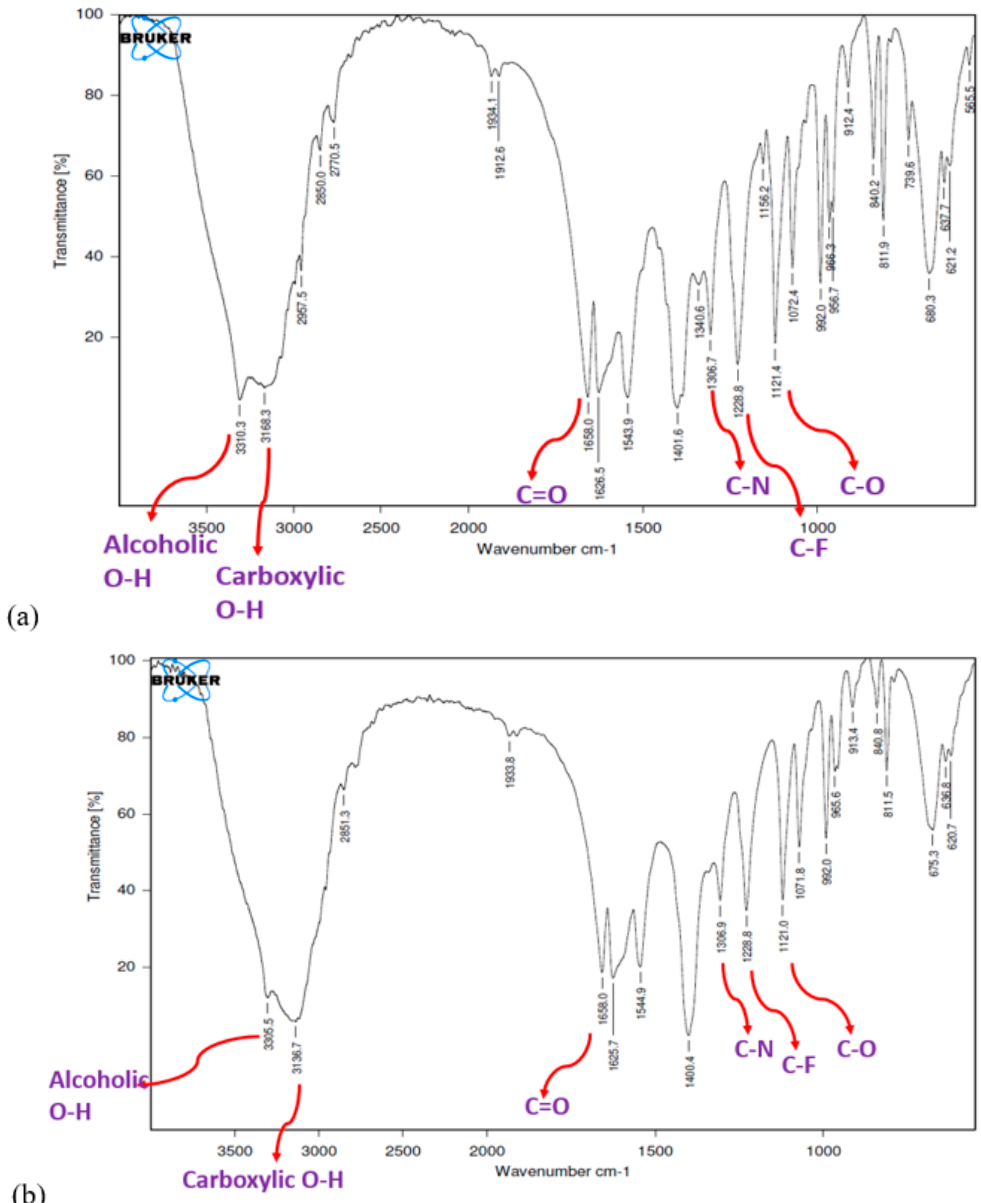
Figure 6. ( a ) Pure Fluvastatin ( b ) Optimized formulation FTIR Spectras.